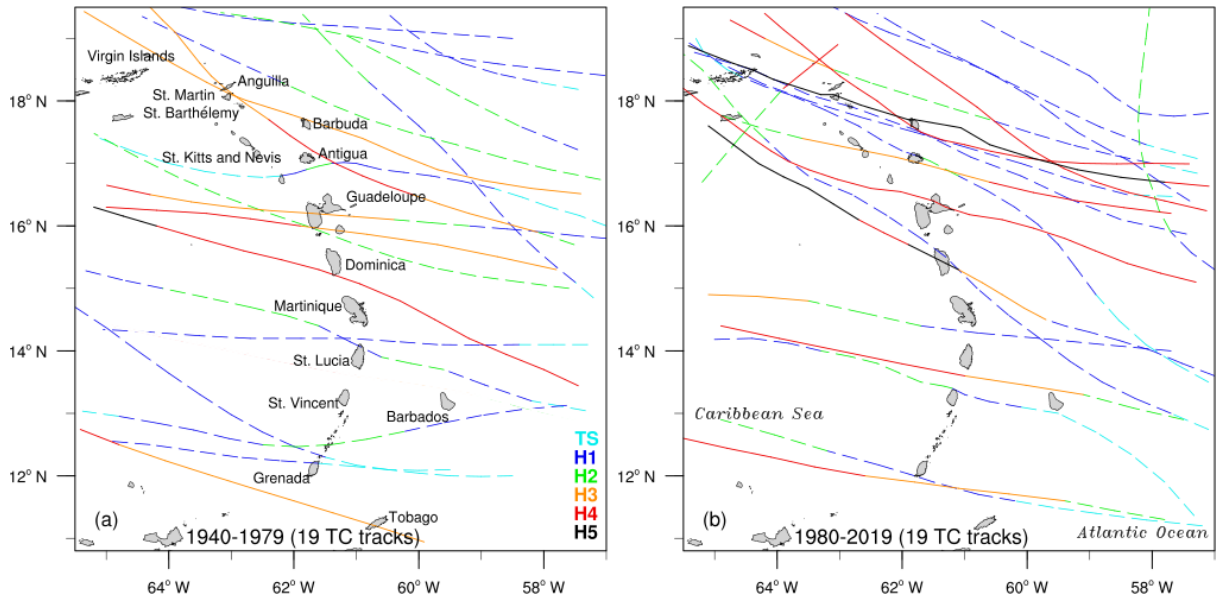
Figure 1. Historical tracks of hurricanes that struck the Lesser Antilles in 1940–1979 (a) and in 1980–2019 (b) . Colors indicate the hurricane intensity along the track. H1, H2, H3, H4, and H5 stand for category 1, 2, 3, 4, and 5, respectively, on the Saffir–Simpson scale. TS (tropical storm) corresponds to wind speeds lower than 64kn. Dashed lines indicate the track sections with an intensity weaker than category 3 on the Saffir–Simpson scale. Only hurricane-force events are